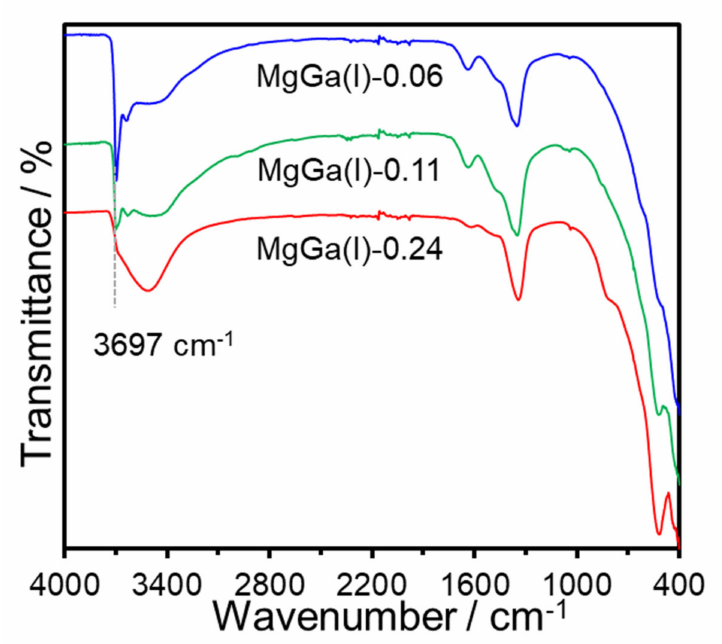
Figure 3. IR spectra of MgGa(I)-x (x = 0.24, 0.11, and